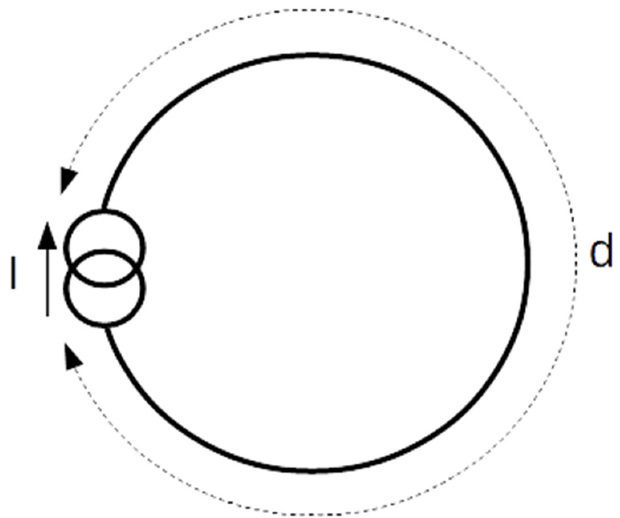
Figure 1. Schematic of the communications loop (signal path) excited by a current generator (I), with a perimeter d.